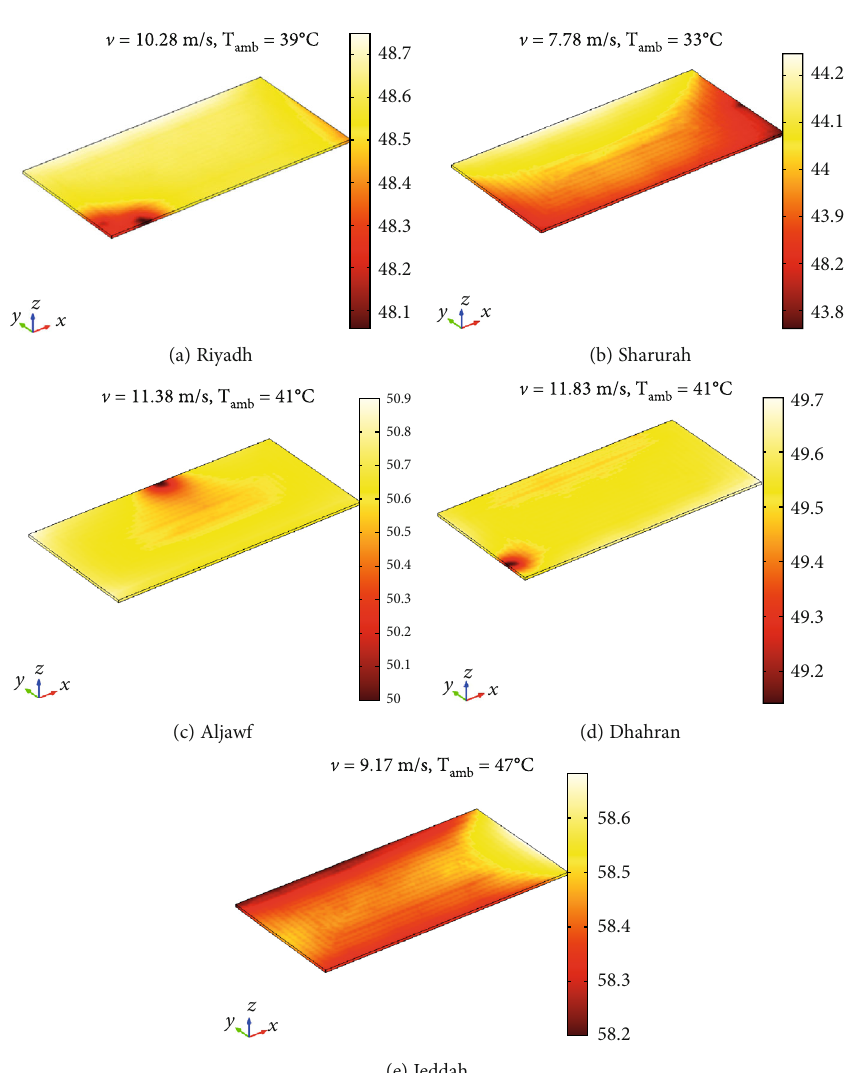
Figure 2: Temperature distribution of a PV plate at